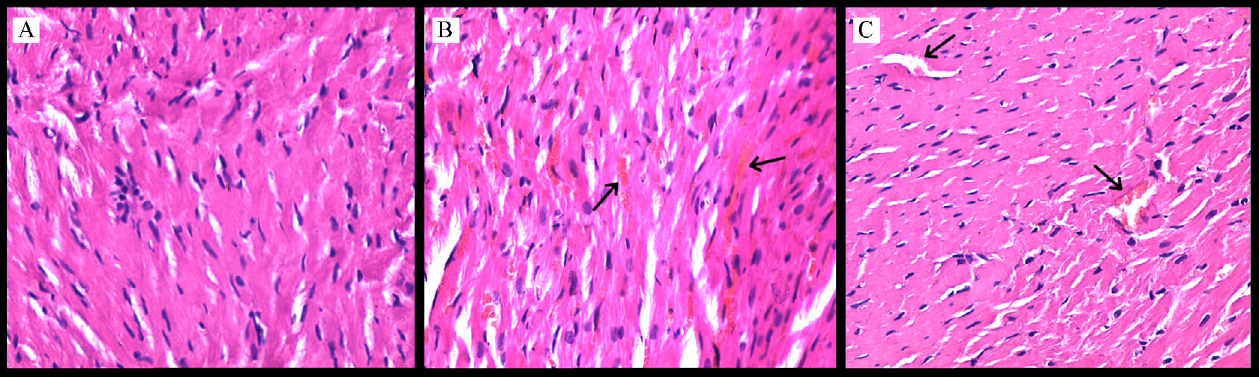
Fig. 1 - Acetaminophen attenuates the morphological changes associated with aortic I/R-induced myocardial injury. %” (A) In the control group, the normal appearance of cardiac myofibrillar. (B) In the aortic I/R group, changes in the myofibrillar swelling and thick focal hemorrhage. Erythrocytes are seen as evidence of an intense hemorrhage (black arrows) (C) In the aortic I/R + acetaminophen group, there is mild myofibrillar swelling and focal hemorrhage (blood vessels have a normal appearance) (black arrows). Heart sections are stained by hematoxylin and eosin, and examined by a light microscope. Magnification: original ×200; scale bar: 300